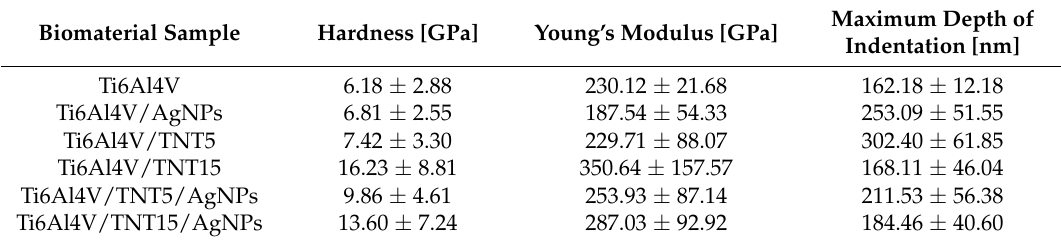
Table 5. Mechanical properties (hardness, Young’s Modulus and maximum depth of indentation) of